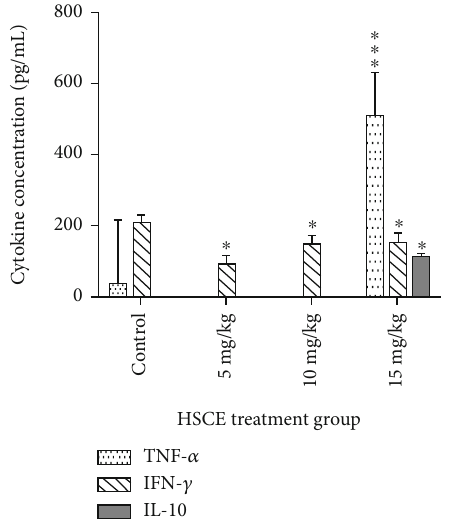
Figure 3: E ff ect of oral administration of the Haliclona ( Soestella ) sp. sponge crude extract (HSCE) once daily for 14 consecutive days on rat plasma cytokine levels of TNF- α , IFN- γ , and IL-10. Results are expressed as mean ± SEM ( n = 6/group ). ∗ p < 0 : 05 and ∗∗∗ p < 0 : 001 (Mann-Whitney U